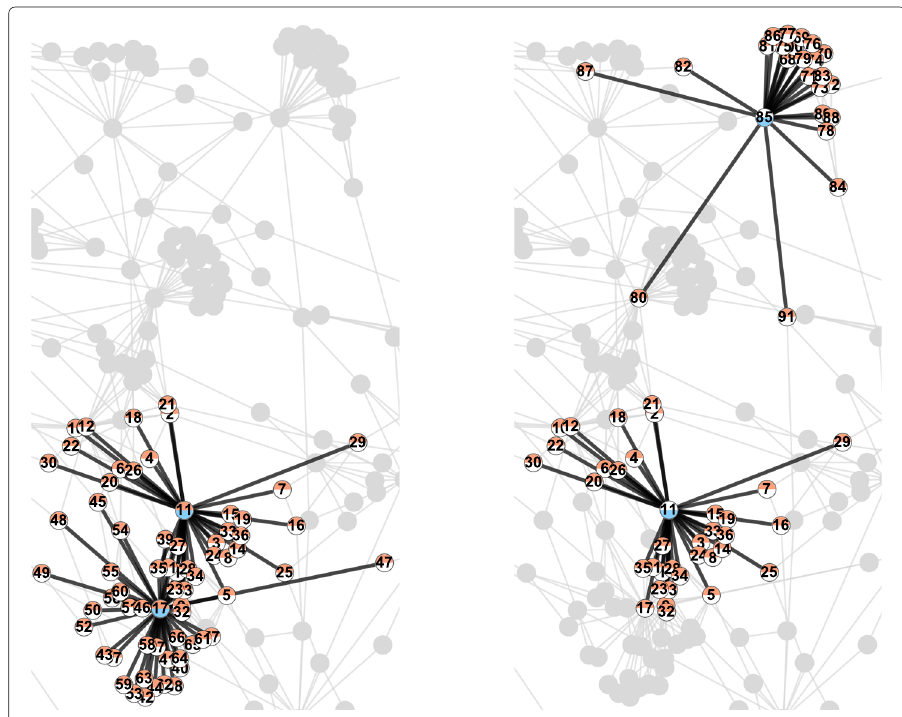
Fig. 10 Two bi-patterns q = ( q 1 , ∅ ) and q (cid:2) = ( q (cid:2) 1 , ∅ ) with homogeneity less than 0.003. On the left the core subgraph represents the two cooperating stars Jianyong Wang and Lizhu Zhou who share labels q 1 = {data,databas,efficy,graph,keyword,mine,query,search,web,xml}. The core subgraph on the right represents the two stars Jianyong Wang and Mohammed Zaki sharing labels q (cid:2) 1 = {cluster,data,efficy,frequ,graph,mine,pattern,query} in a competitive configuration. See Table 4 the authors associated to these